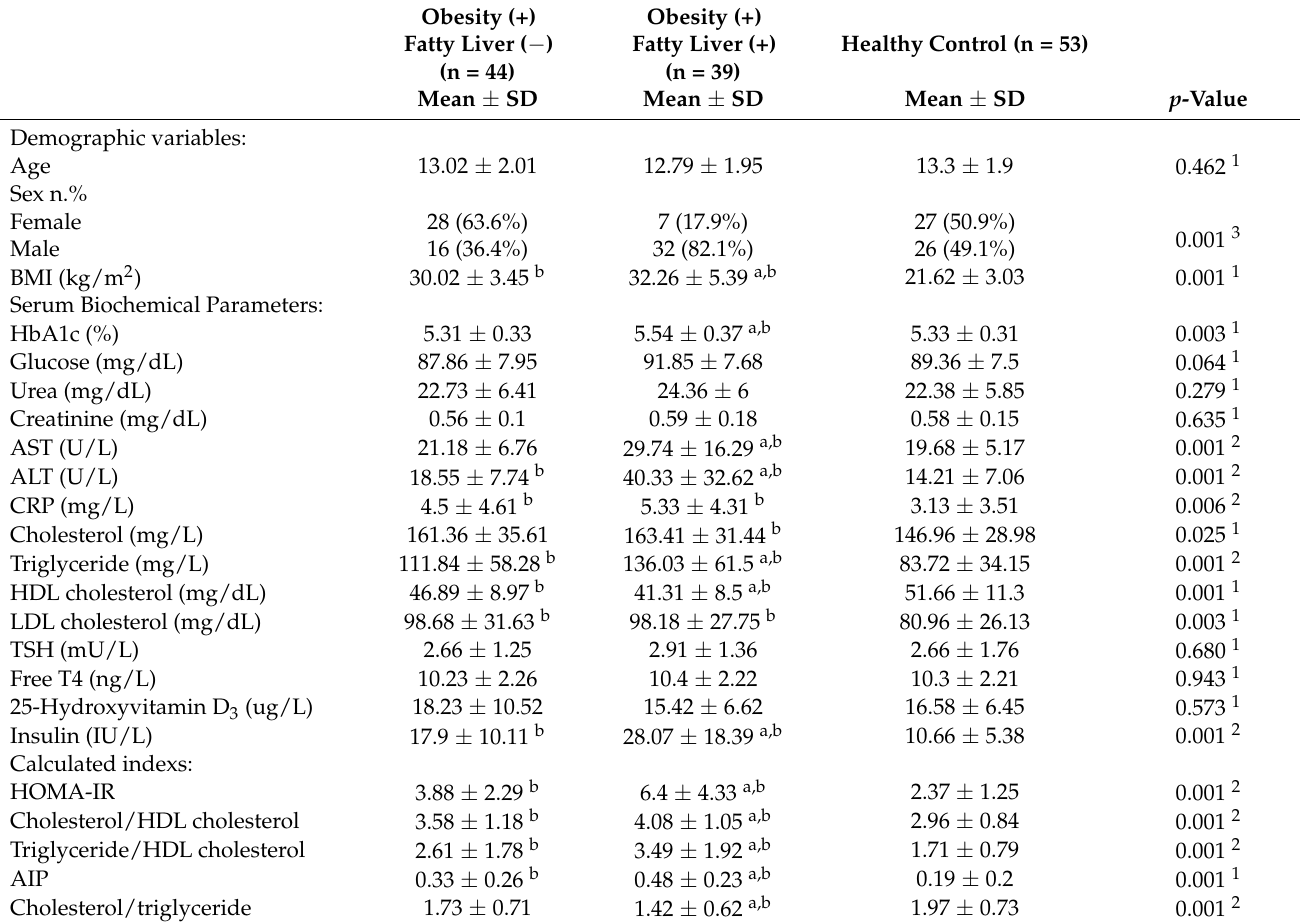
Table 2. Data on obese adolescents and healthy controls with and without fatty liver.